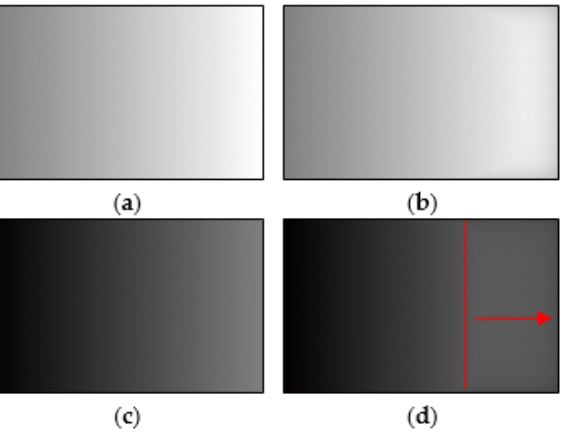
Figure 6. High Saturated Pixel Brightness Sensitivity Slope (SPBSS) vs. Low SPBSS. ( a ) High SPBSS original image; ( b ) High SPBSS image after excessive dimming; ( c ) Low SPBSS original image; ( d ) Low SPBSS image after excessive